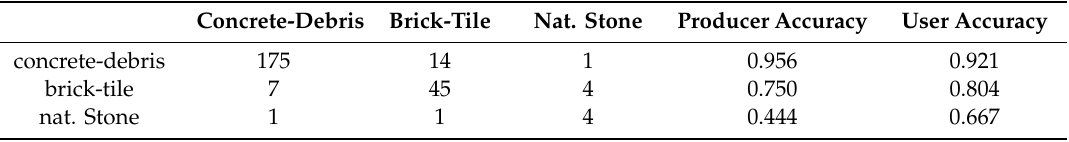
Table 6 . Accuracy parameters of three recoded PED maps obtained using the 0.45 PMA threshold (252 samples).